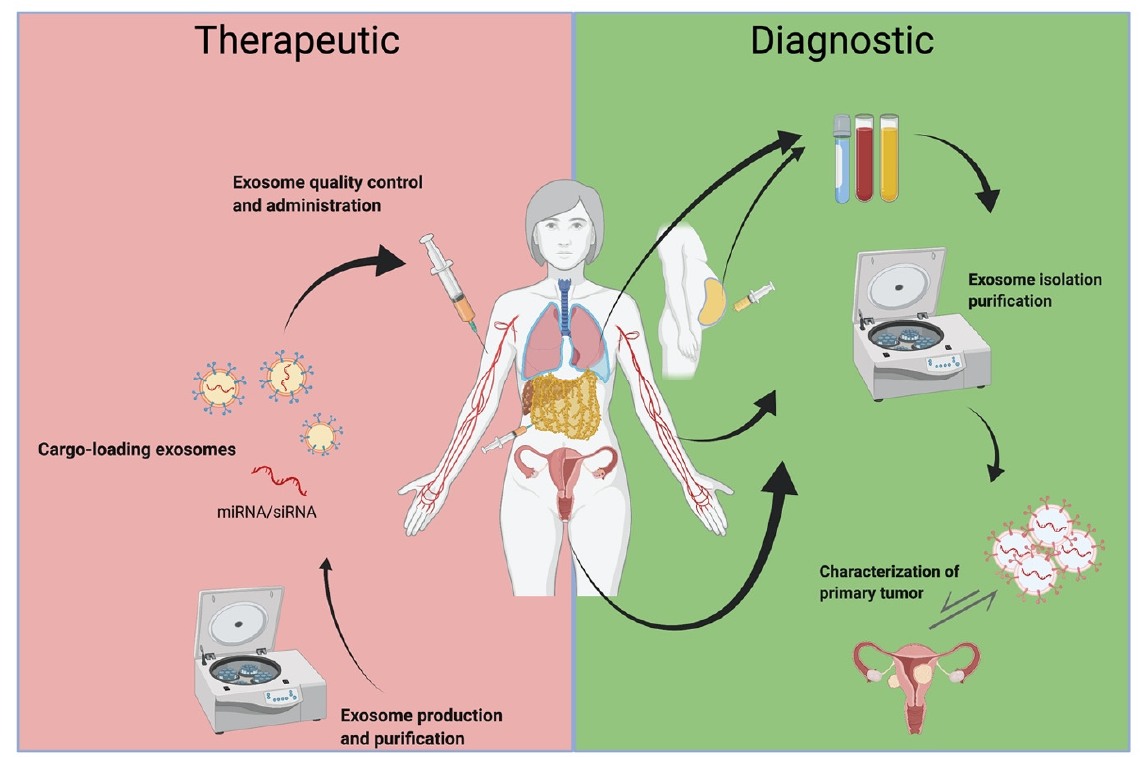
Figure 4. Clinical utility of exosomes in gynecologic malignancies. Created with BioRender.com (accessed on 20 October 2020).